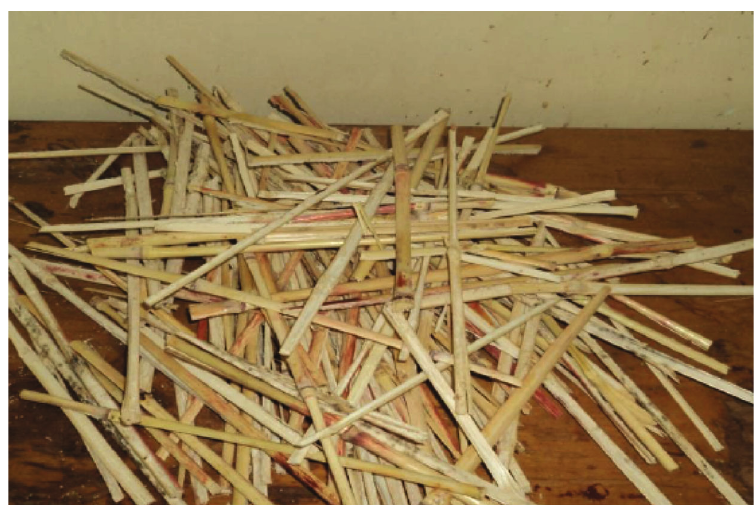
Figure 1: Gadam sorghum stalk